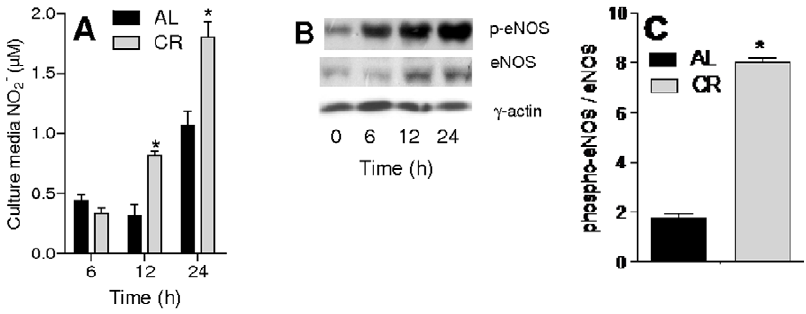
Figure 1. CR serum increases NO 2 2 release and promotes eNOS and nNOS phosphorylation. ( A ) Culture media NO 2 2 was measured over time after incubation in AL or CR sera, as indicated. ( B ) eNOS phosphorylation and expression over time after switching from AL to CR serum. Representative blots are shown. ( C ). Quantification of eNOS phosphorylation after 24 h in AL or CR sera. *p , 0.05 versus AL. doi:10.1371/journal.pone.0031155.g001 PLoS ONE |